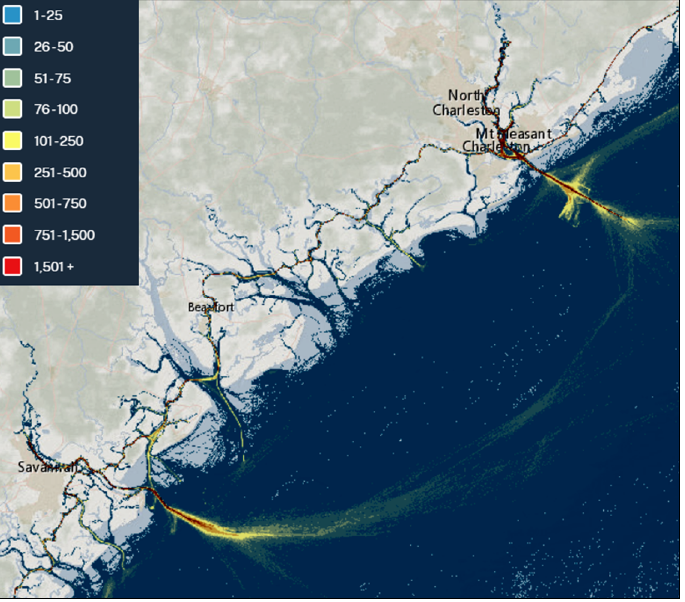
Figure 3. Annual AIS transit vessel counts for the area of interest in the observed period.